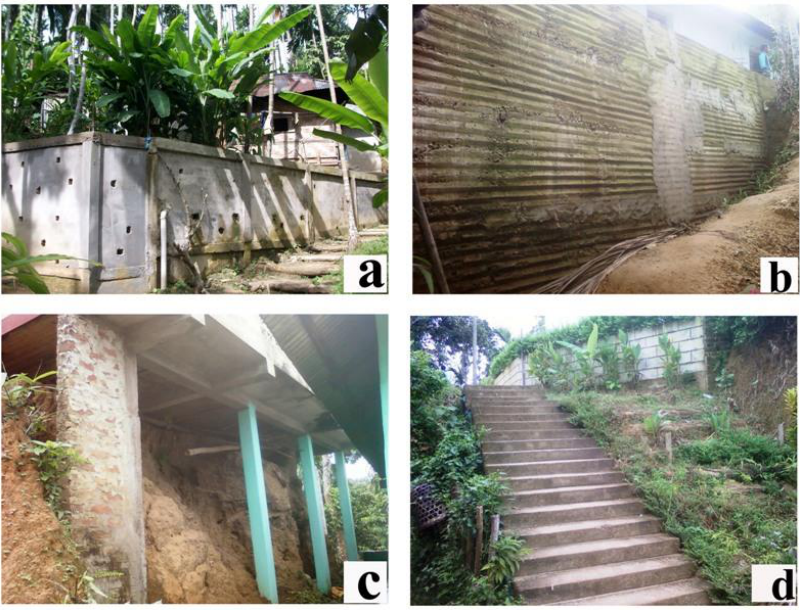
Figure 6. Construction of protection wall surrounding the ( a ) houses and ( b ) locality; changing design and patterns of ( c ) houses and ( d ) staircases.